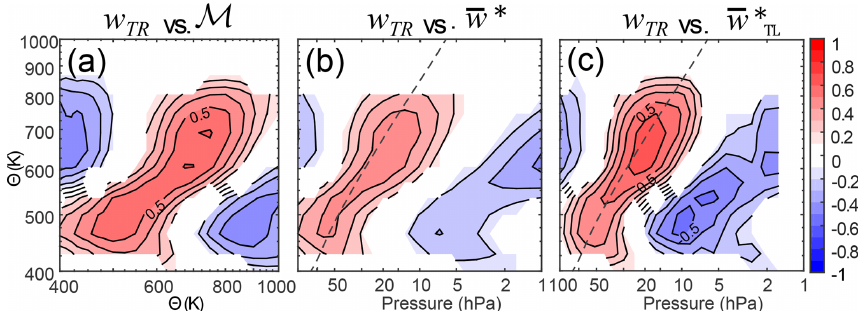
Figure 8. Correlation coefficient of the interannual variability of w TR with (a) the global diabatic circulation and (b) the residual circulation vertical velocity, ¯ w ∗ , at different levels in the stratosphere. The climatological relationship between pressure and potential temperature (averaged between 20 ◦ S and 20 ◦ N) is shown in (b) and (c) by the dashed gray line.